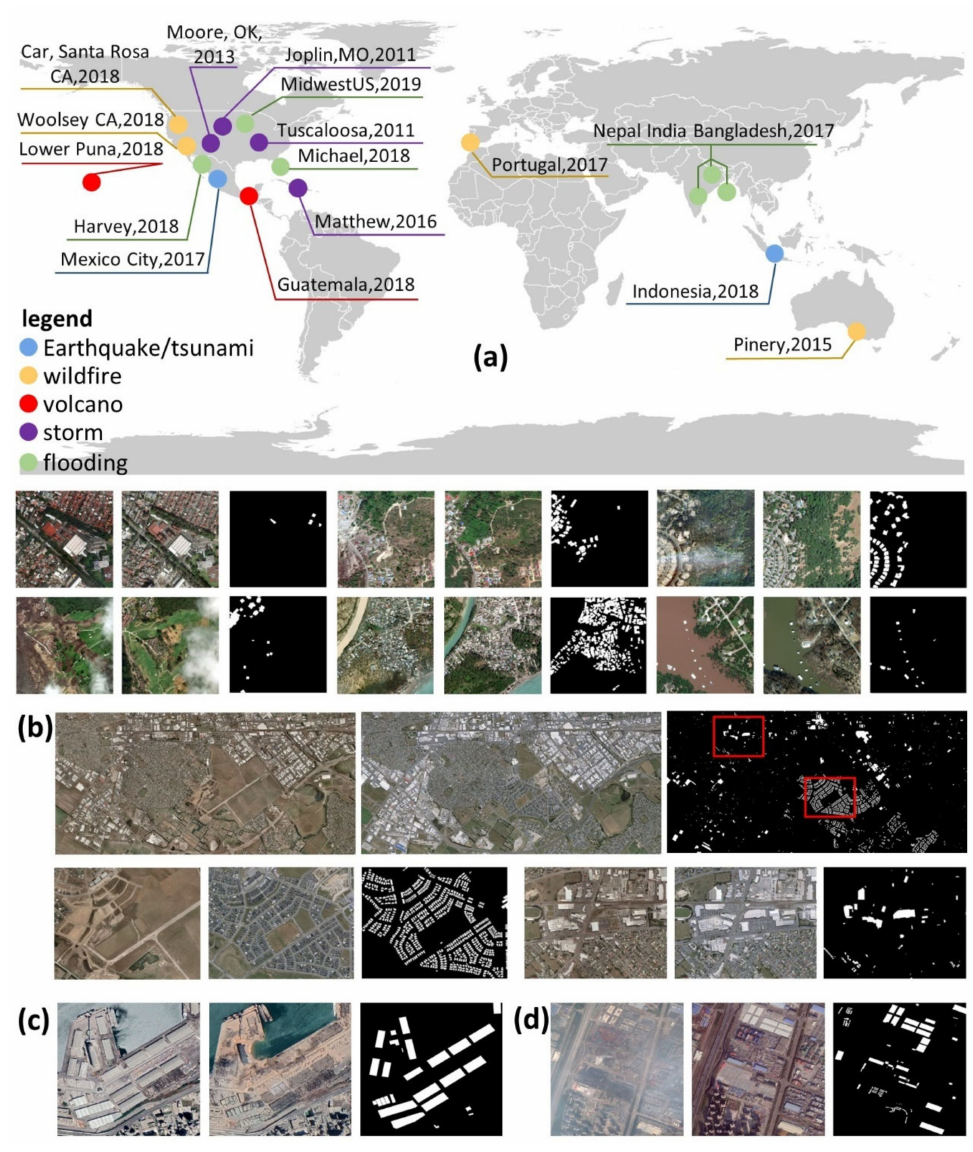
Figure 1. Overview of datasets. ( a ) The xView2 building damage assessment dataset. ( b ) The WHU Building Dataset. ( c ) The Beirut port dataset. ( d ) The Tianjin Binhai New Area